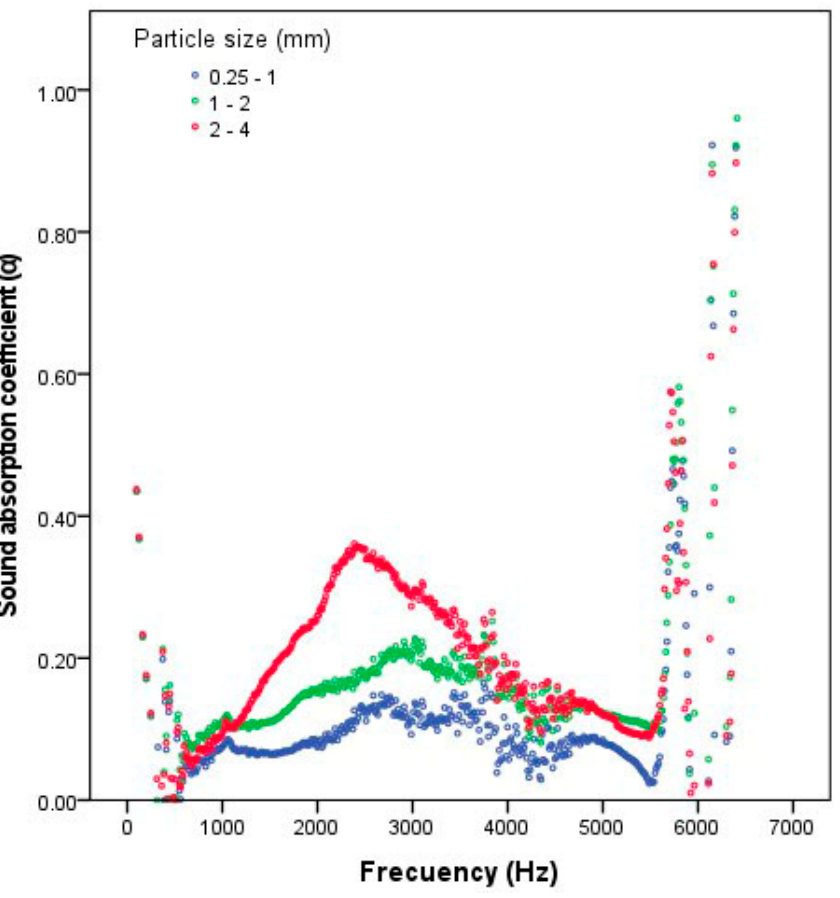
Figure 2. Absorption coefficient results according to the particle size of the panels. The graphs of the different types of panels indicated that there are significant differ- ences among the boards, especially in the bands from 1250 to 4000 Hz. This may be due to the porosity of the boards due to the gaps between the particles. With larger particles (2.00 to 4.00 mm), a higher porosity is observed in the particleboards. Boards are classified in building construction [26] according to their acoustic coefficient: class D boards have values between 0.30 to 0.5, class E between 0.15 to 0.25, and boards with lower acoustic coefficient values are unclassified. In general, mulberry boards with 2 to 4 mm particles are classified as class E acoustic absorbent boards, except in the frequency range from 500 to 1000 Hz.